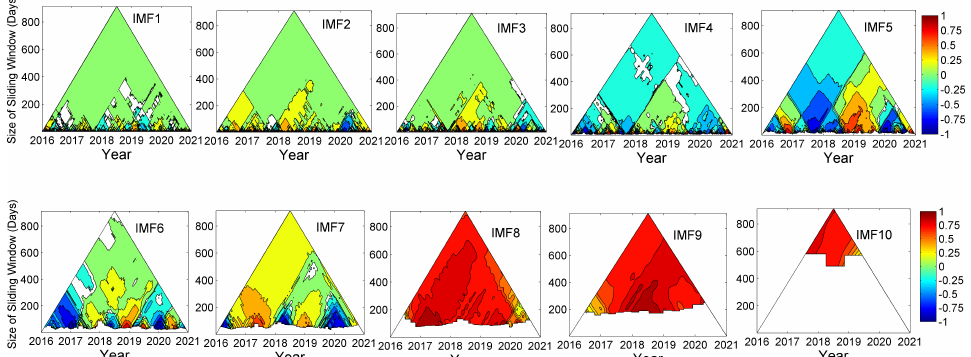
Figure 13. TDIC plots between relative humidity ( Rh ) and wind direction ( WD ). The white spaces imply that correlation is not significant at the 5% level.